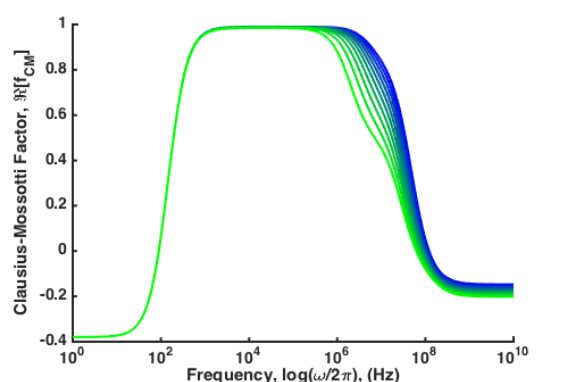
Figure 3. A multi-shell model that incorporates the presence of increasing volume fraction of Hepatitus-C viral vesicles in an example ellipsoidal hepatocyte model. The primary variation that results is a change in the magnitude of pDEP at high